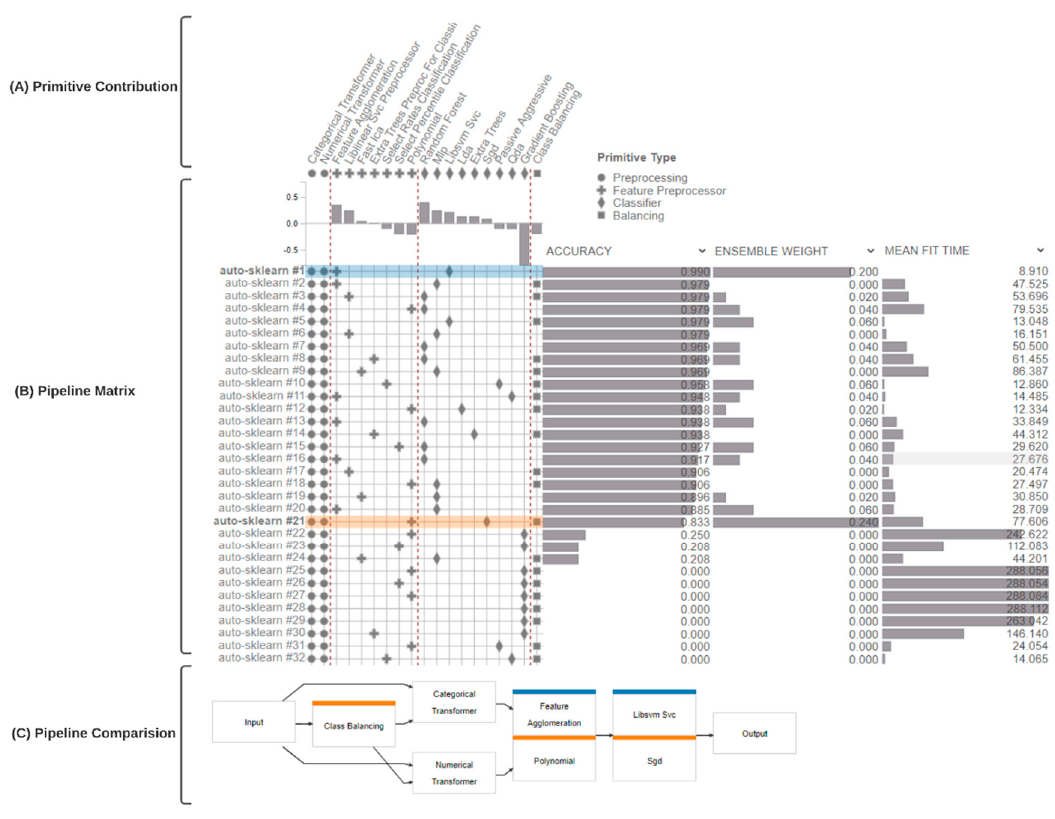
Figure 7. PipelineProfiler applied to the analysis of tuna meat classification pipelines generated by the AutoML system.